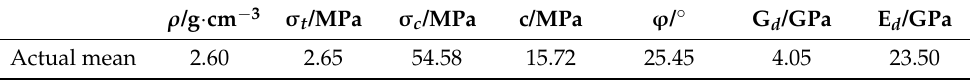
Table 6. Physico-mechanical parameters of samples of siltstone in the bar service area.